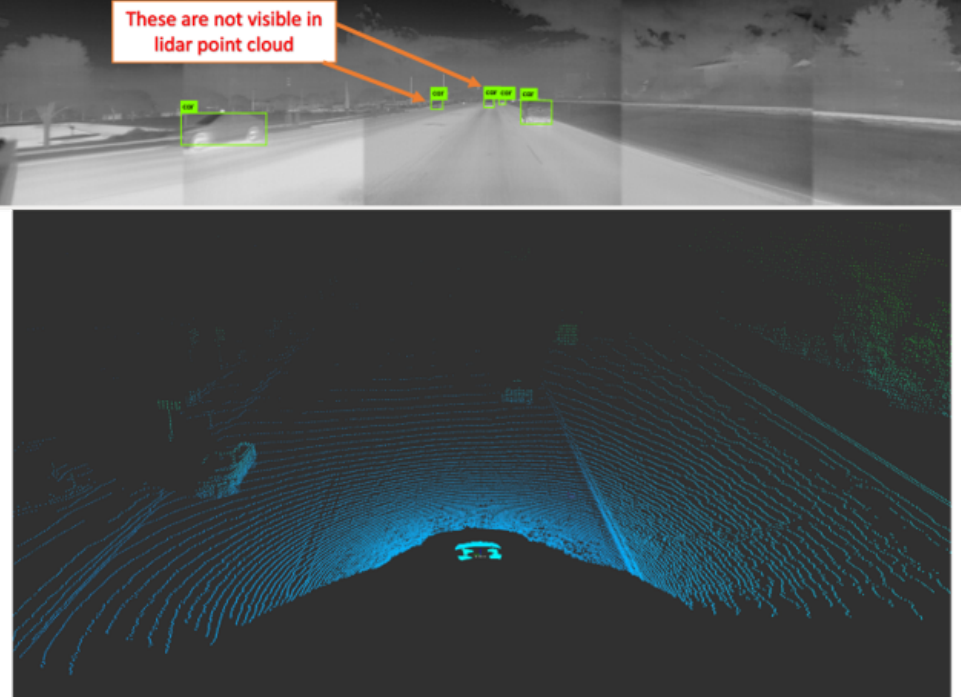
Figure 12. The thermal camera system was able to pick up far-away vehicles not visible on the lidar. The green boxes represent the output of the YOLO object detector picking up cars from the thermal image.